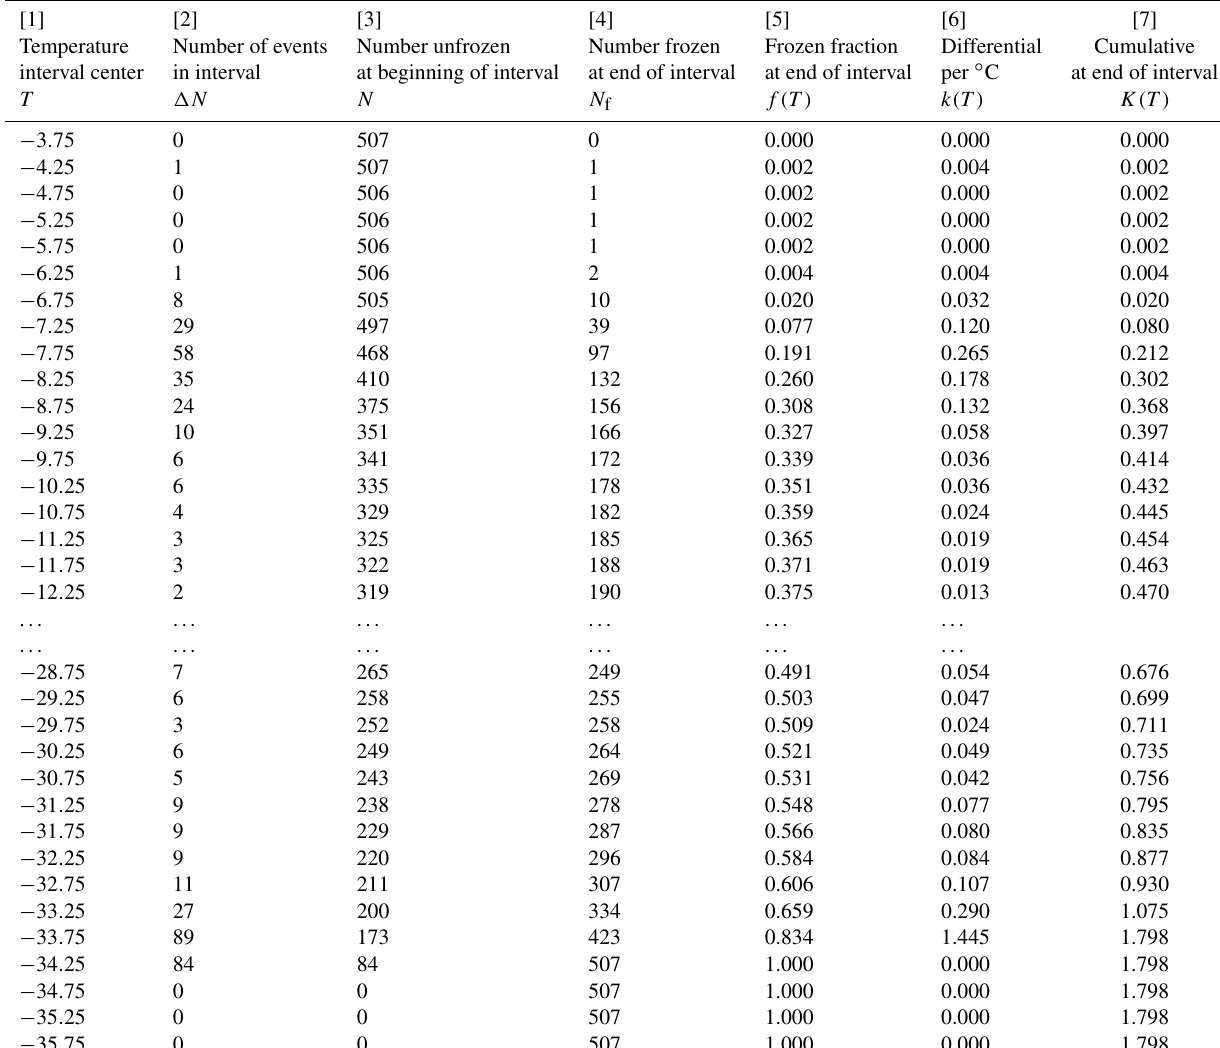
Table 2. Differential and cumulative spectra for the Snomax TM sample with 0.5 ◦ C intervals, as discussed in Sect. 5. Ellipses indicate the range in which not all temperatures are included, for